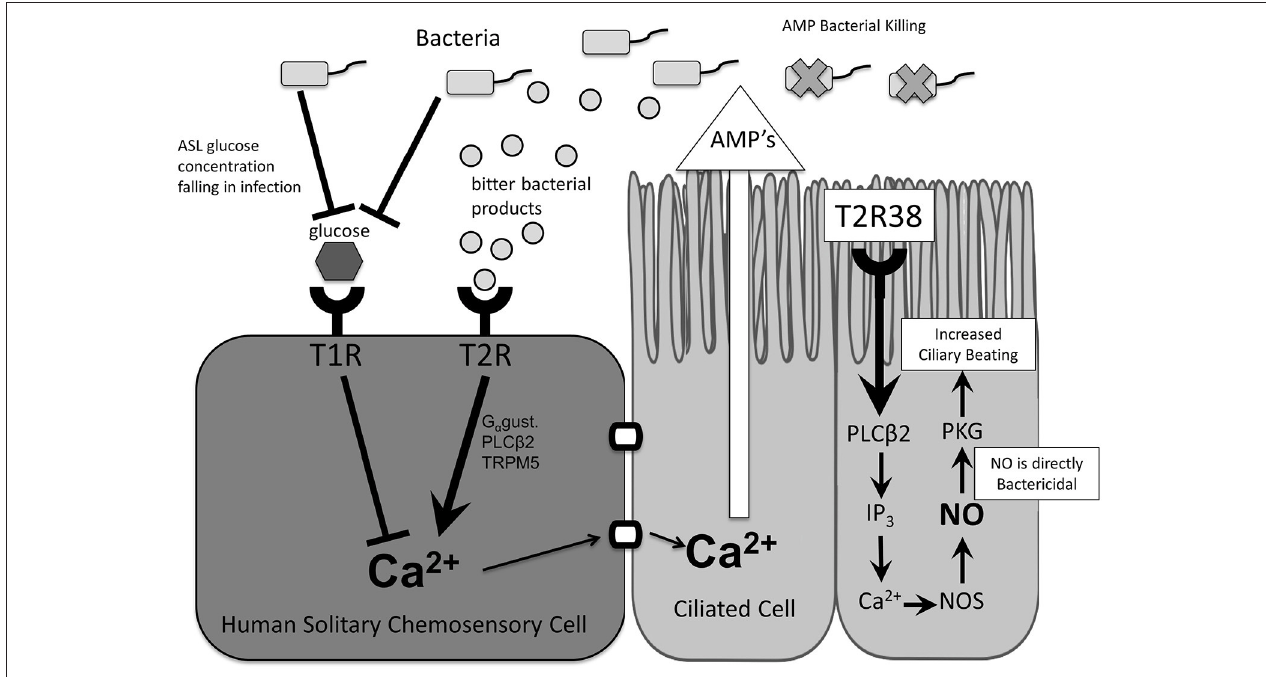
FIGURE 1 | Taste receptor function and downstream effects. In ciliated cells, stimulation of T2R38 and taste-receptor signaling results in activation of innate immune mechanisms including increased mucociliary clearance and nitric oxide release. In solitary chemosensory cells, stimulation of T2Rs results in a calcium-mediated release of antimicrobial peptides. This response is regulated by T1Rs such that under physiologic airway surface liquid glucose levels the T2R-mediated immune activation is inhibited. AMP, antimicrobial peptides; ASL, airway surface liquid; Ca 2 + , calcium ion; G α gust, G α gustducin; IP3, inositol trisphosphate; NO, nitric oxide; NOS, nitric oxide synthase; PLC β 2, phospholipase C isoform β 2; T1R, sweet taste receptor; T2R, bitter taste receptor; TRPM5, transient receptor potential cation channel subfamily M member ion